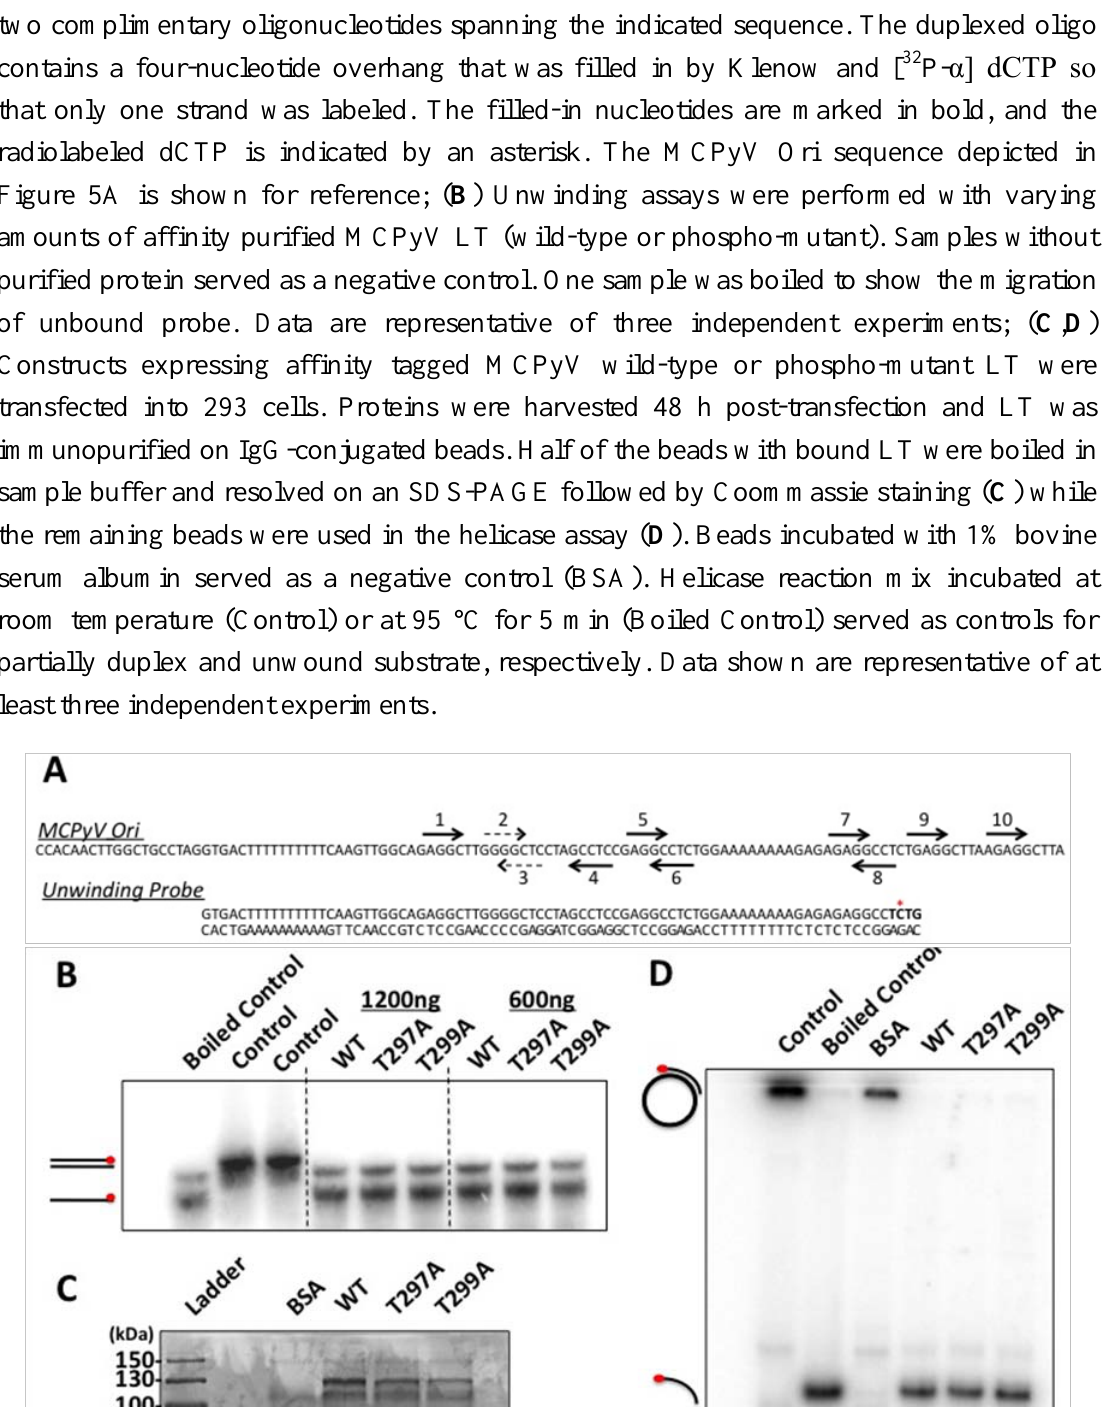
Figure 6. MCPyV LT phospho-mutants have similar unwinding and helicase